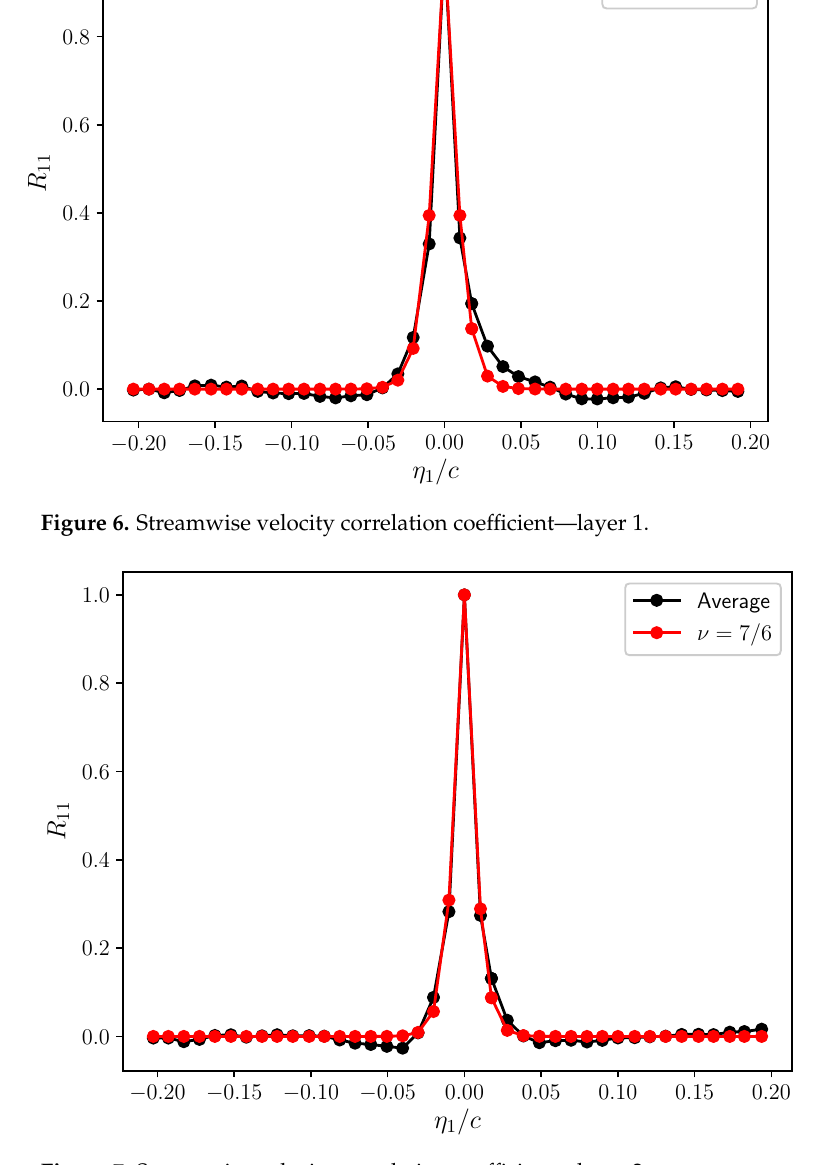
Figure 7. Streamwise velocity correlation coefficient—layer